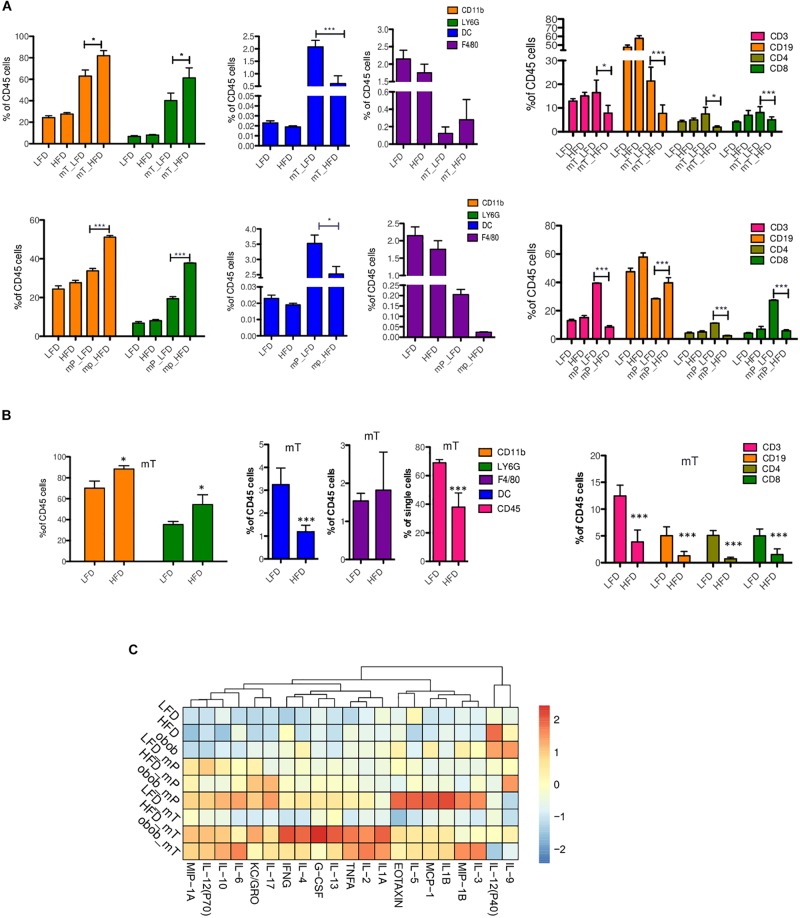
Immune and cytokine profiles of organoid-transplant model systems. Cytofluorimetric analysis for immune cells in (A) peripheral blood of mP and mT organoids model bearing-mice and (B) in the resected pancreata of mT organoids model bearing-mice. The data were shown as a percentage relative to the CD45+ cell population. Three independent experiments are shown; (C) Multiplex analysis of proinflammatory circulating factors. Plasma from peripheral blood was collected from each group of mice (n = 3) before and after (LFD n = 3, HFD n = 3, Ob/Ob n = 2) (35 days) mP and mT organoid injections. Concentrations of proinflammatory cytokines were analyzed using Luminex technology. Concentrations of cytokines (pg/mL) were calculated. The values for each cytokine (chemokine was reported as fold increase of each protein respect to expression value of mP LFD model as control. The mean values and standard deviation are shown. ***, p < 0.001; *, p < 0.05 by two-tailed unpaired Student’s t-tests.